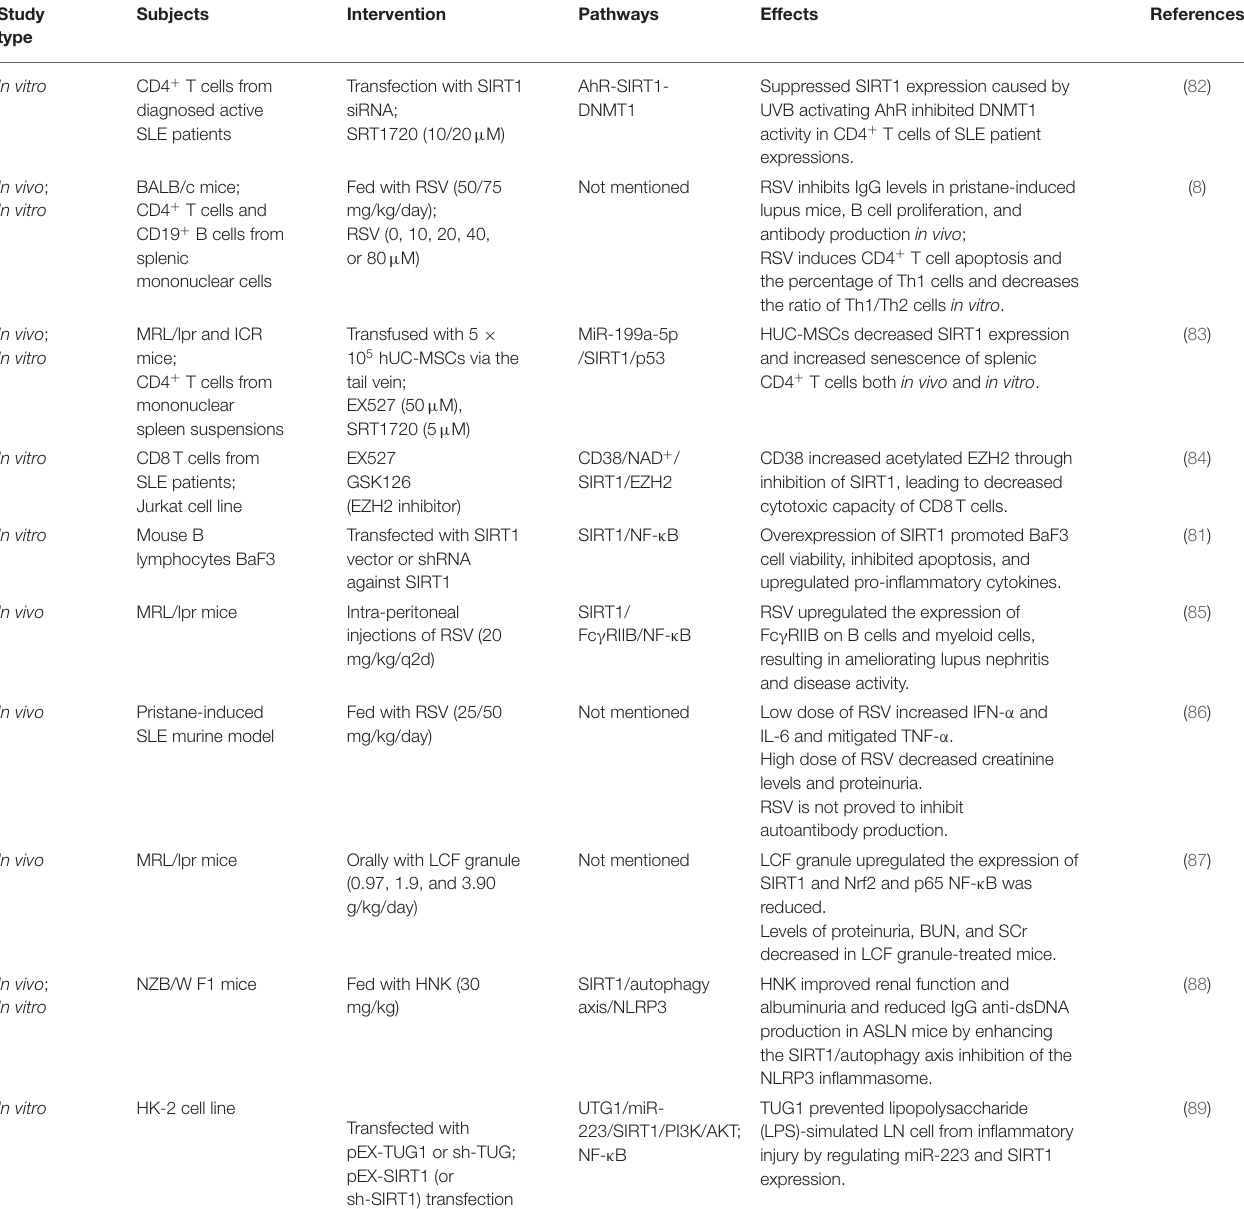
TABLE 2 | The functional studies of SIRT1 in